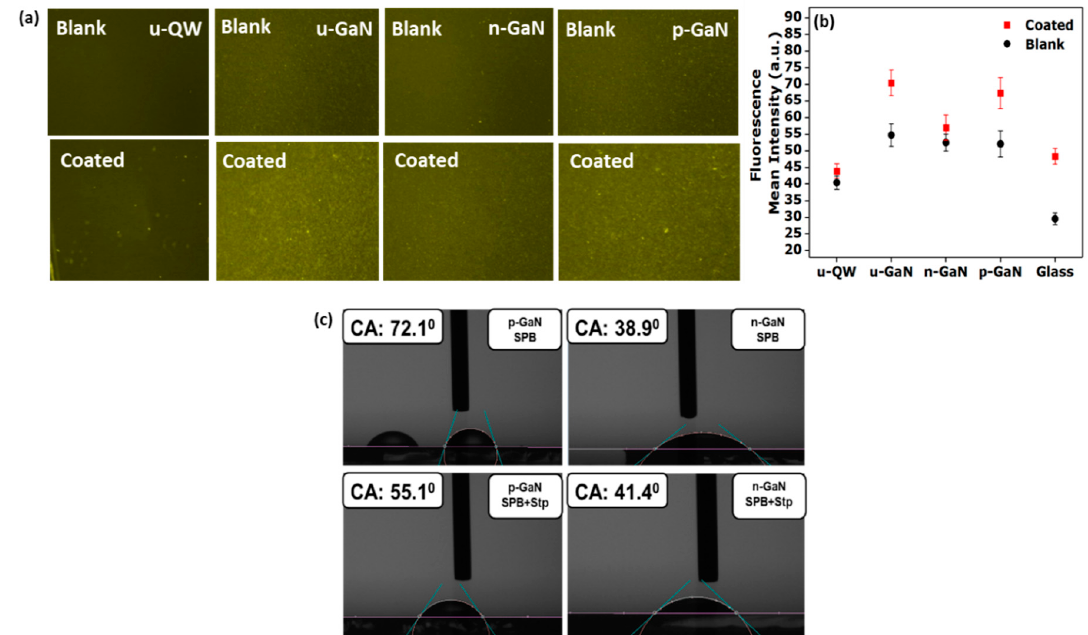
Figure 5. ( a ) Fluorescence images of biomolecule-functionalized undoped QW (u-QW, D ), undoped GaN (u-GaN, C ), Si-doped GaN (n-GaN, B ) and Mg-doped GaN (p-GaN, A ). ( b ) Mean fluorescence intensity (a.u.) of biomolecule coated substrates. ( c ) The contact angle of water drops on bare and silane-PEG-biotin (SPB) coated p-GaN ( A ) and n-GaN ( B ) surfaces with and without streptavidin (Stp).